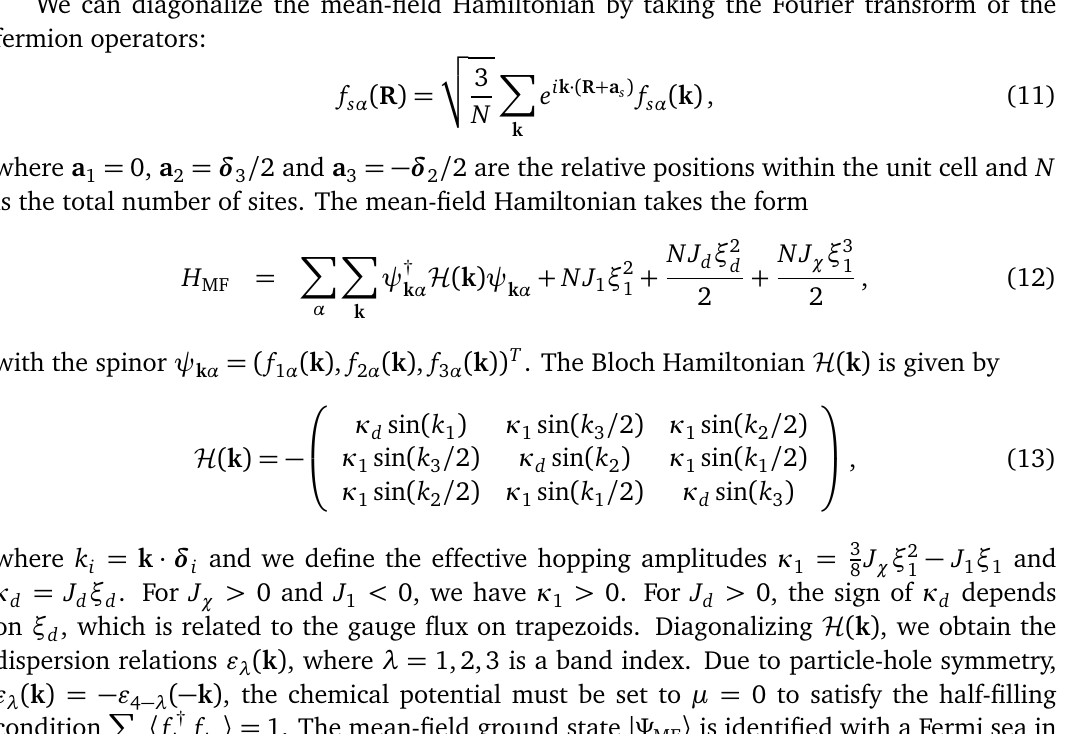
( k ) and (cid:34) ( k ) , along 1 3 /κ /κ < 2, the bands . For κ d d 1 1 /κ = 2, the bands cross d 1 /κ > d 1